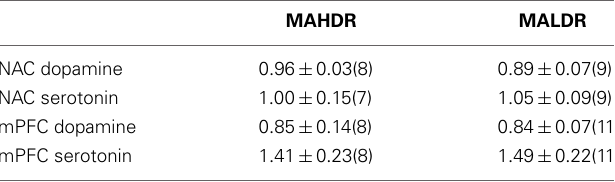
The data represent the mean ± s.e.m. of the number of animals indicated in parentheses.